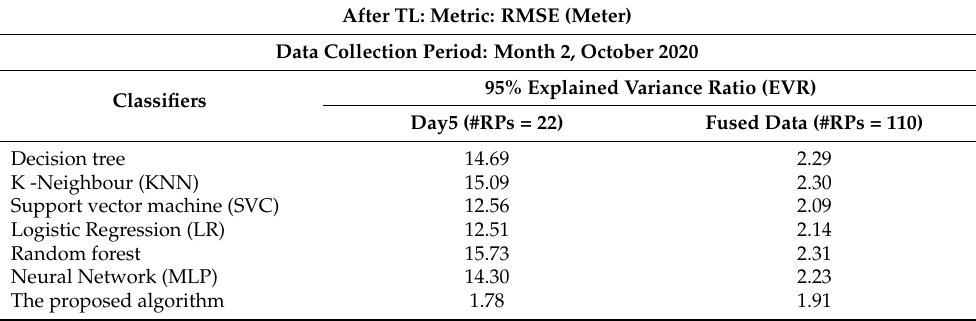
Table 10. Models Vehicle’s indoor parking lots of CSI-based fingerprints of fused data based PCA method.